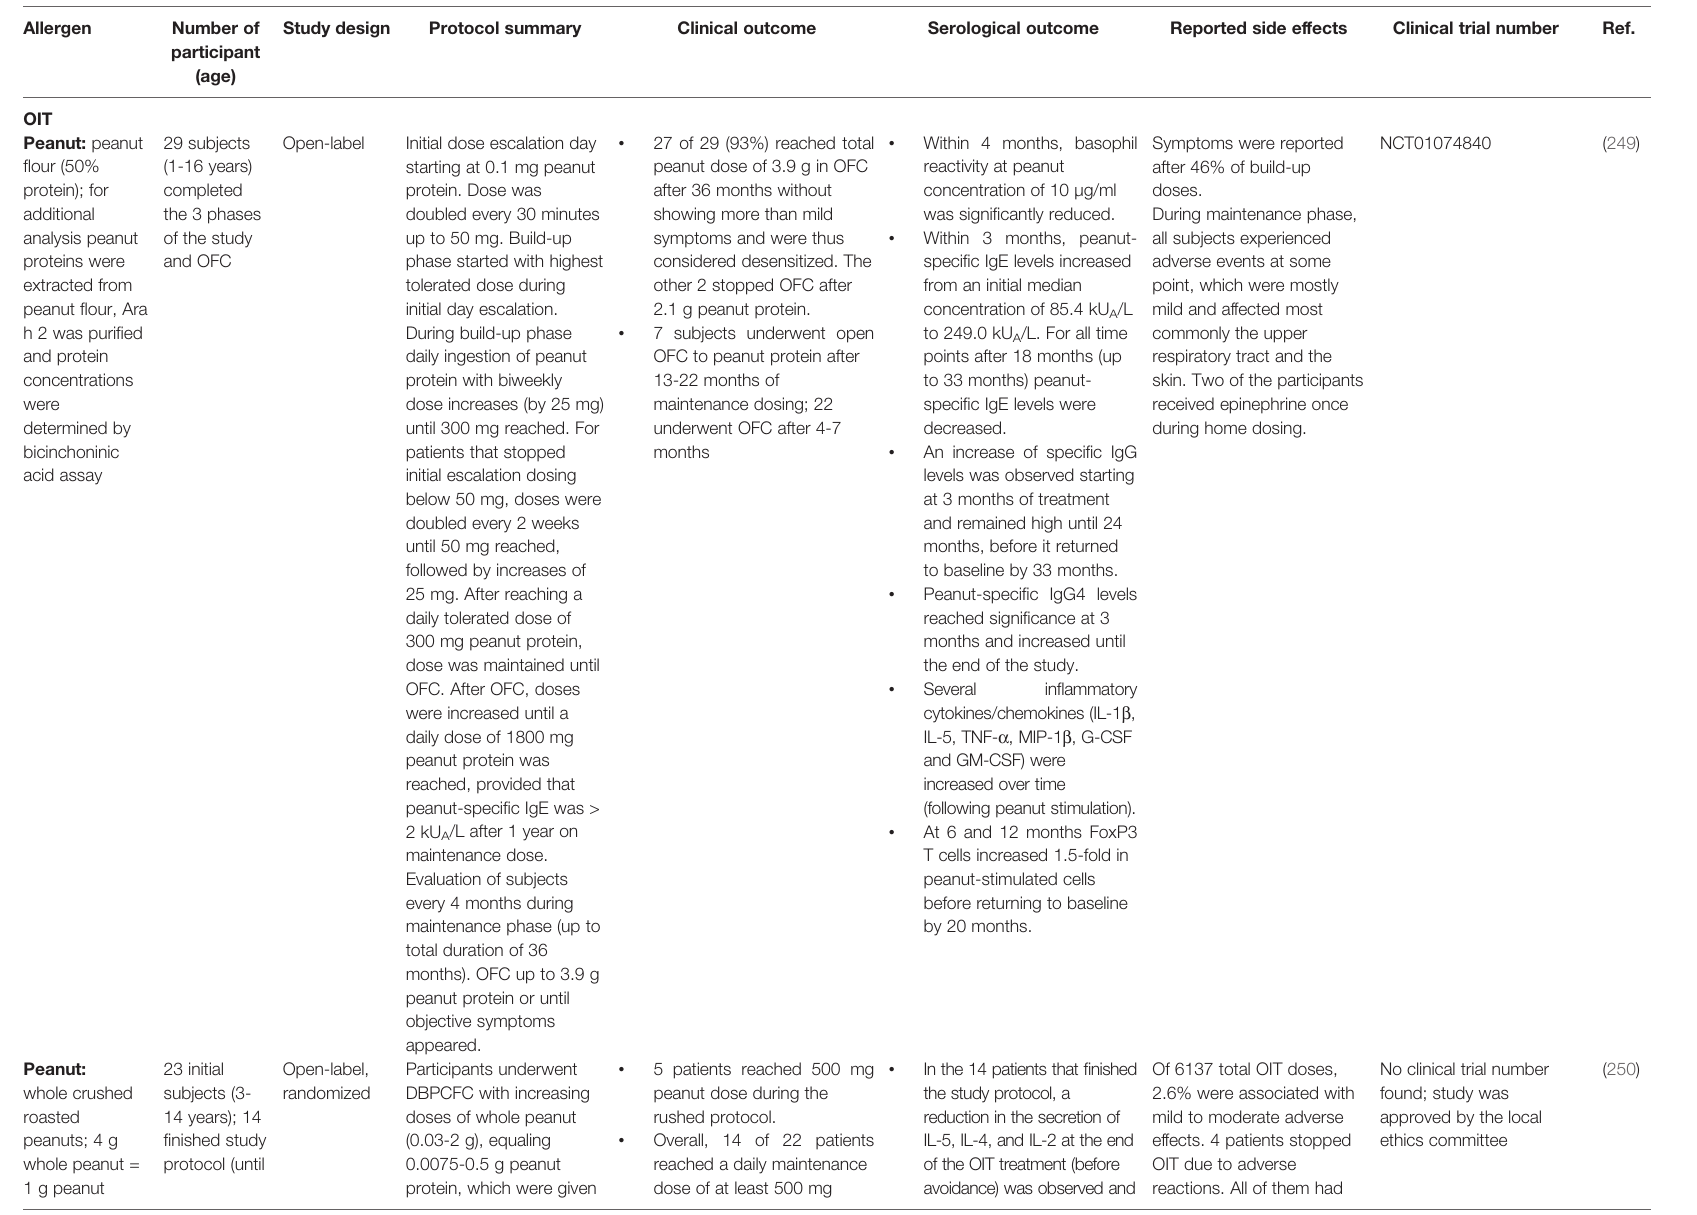
TABLE 3 | Overview of clinical studies performed for peanut and tree nut allergy grouped according to the route of administration (OIT, SLIT, EPIT, rectal application).